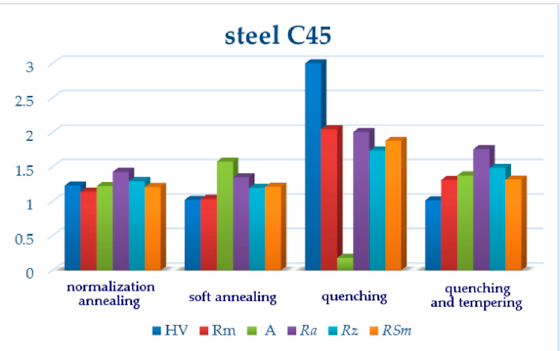
Figure 13. Relative changes of mechanical characteristics and measured surface roughness parameters for C45. All values were normalized, being divided by respective reference values (150 HV, 560 MPa, 16%—values for raw C45 steel [37]; Ra , Rz, RSm values for the upper line of the normalization annealing sample). Quenched and high temperature tempered 37MnSi5 and 30CrV9 were both martensitic with a low proportion of bainite and ferrite (Figures 8 and 12); however, their elemental composition is different, and this leads to a different way of precipitating carbon. Both manganese and silicon tend